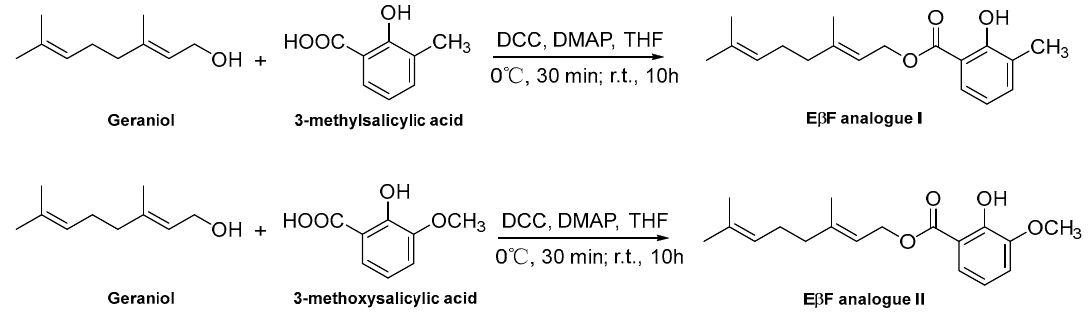
Figure 1. Scheme of the synthetic routes for E β F Analog I and II.